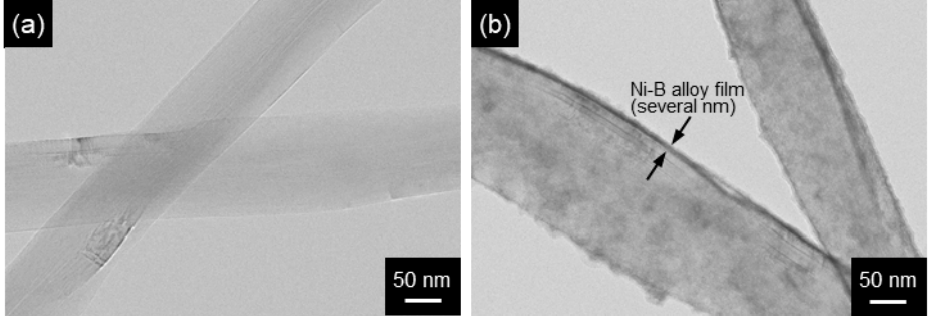
Figure 14. STEM images of Ni-B alloy-coated MWCNTs by electroless deposition: MWCNTs ( a ) before and ( b ) after electroless deposition. Ni-B alloy films of several nm thick are seen. (Figure 14 is adapted from reference [131]).